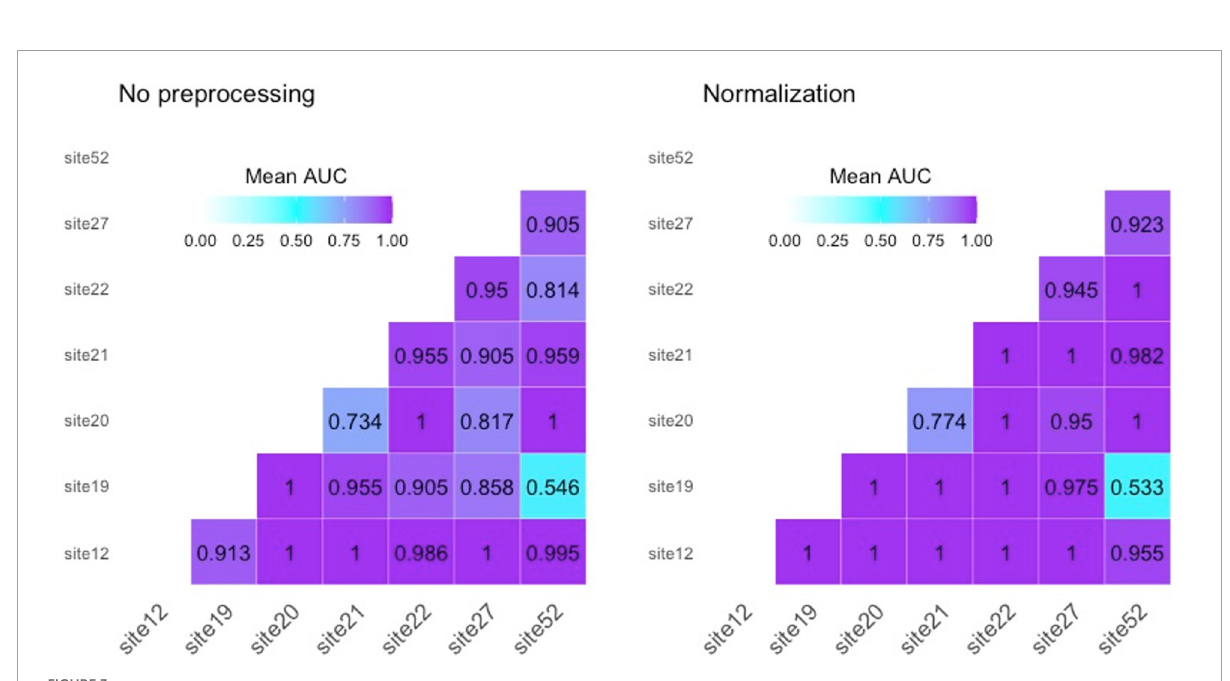
FIGURE3 Area under the receiving operating characteristic curves (AUCs) for “site vs. site” classification on healthy controls. Left panel reports performances for not pre-processed radiomics features; right panel reports results using radiomics features from normalized MRI.